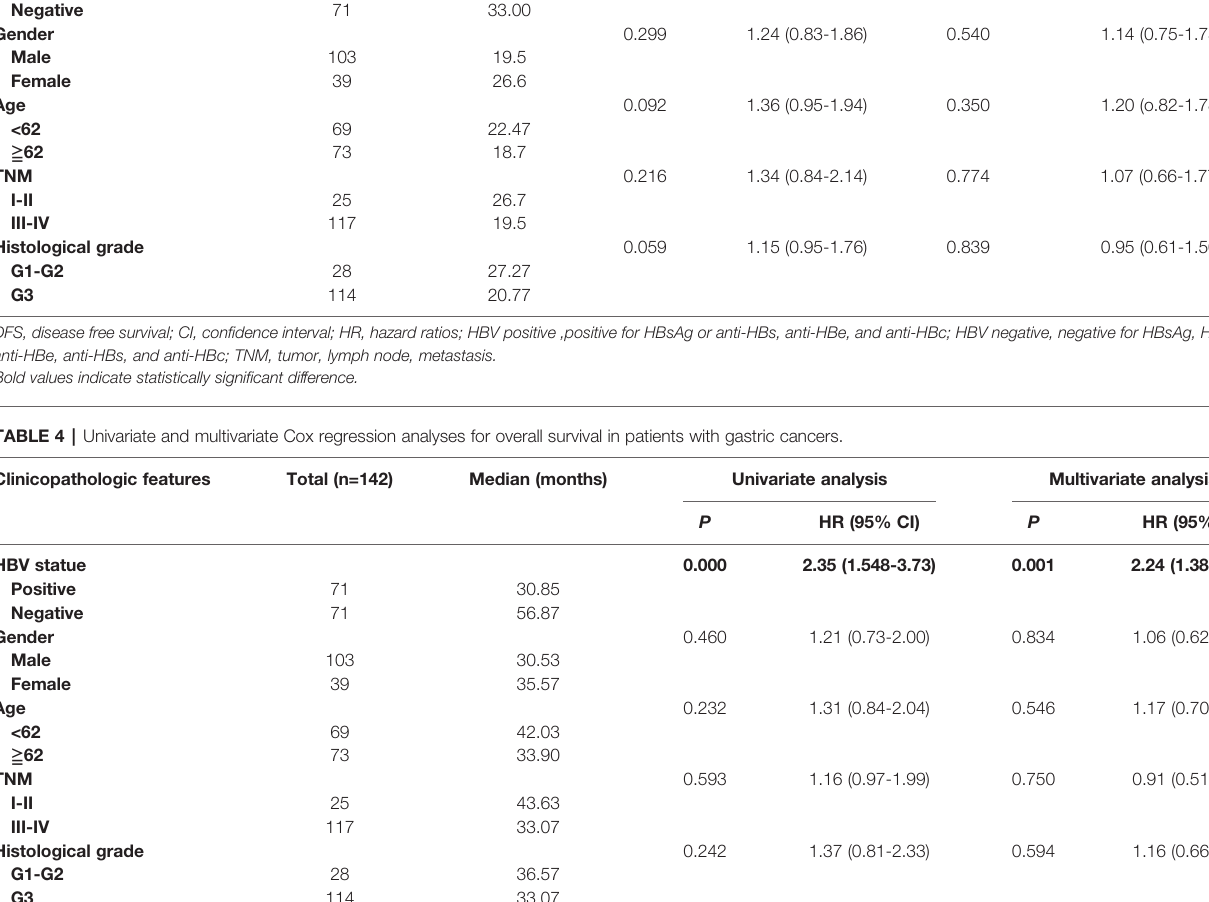
OS,overallsurvival;CI,con fi denceinterval;HR,hazardratios;HBVpositive,positiveforHBsAgoranti-HBs,anti-HBe,andanti-HBc;HBVnegative,negativeforHBsAg,HBeAg,anti-HBe, anti-HBs, and anti-HBc; TNM, tumor, lymph node, metastasis. Bold values indicate statistically signi fi cant difference.